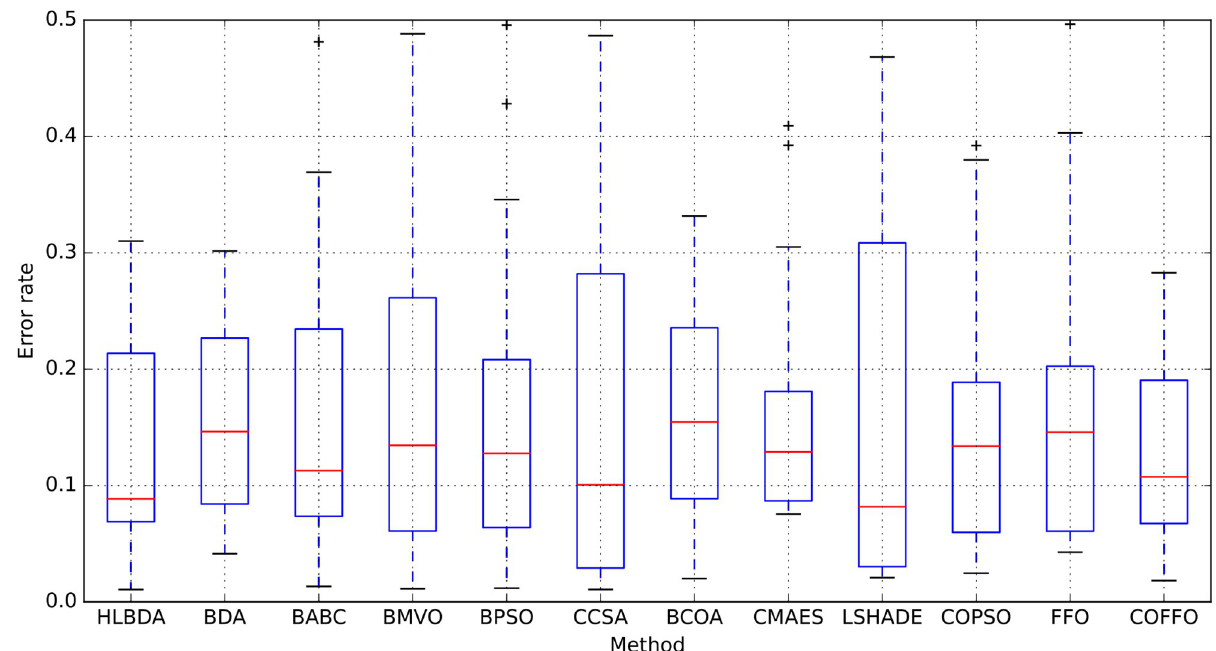
Fig 3. Boxplots analysis of the tested algorithms using average error rate across 21